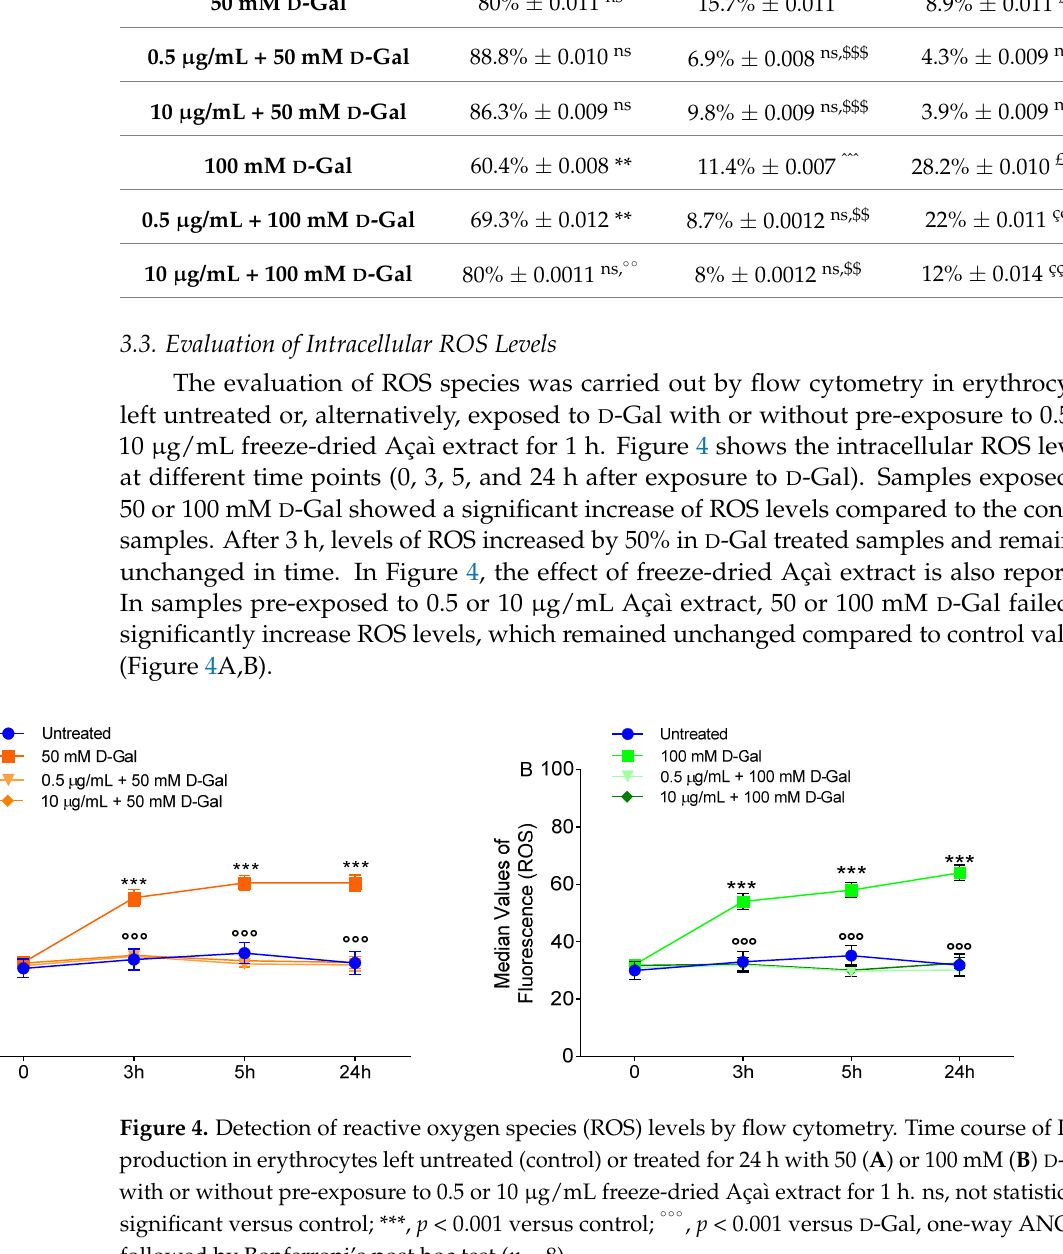
Table 1. Percentage of morphological alterations in erythrocytes left untreated (control) or treated as indicated. Data are presented as means ± S.E.M. from separate three independent experiments, where ns , not statistically significant versus untreated (biconcave shape, acanthocytes, and leptocytes); **, p < 0.01 versus control (biconcave shape); ◦◦ p < 0.01 versus 50 or 100 mM D -Gal (biconcave shape). ˆˆˆ , p < 0.001 versus control (acanthocytes); $$ , $$$ , p < 0.01 and p < 0.001 versus 50 or 100 mM D -Gal (acanthocytes). £ , £££ , p < 0.05, and p < 0.001 versus control (leptocytes); çç , ççç , p < 0.01 versus 100 mM D -Gal (leptocytes); one-way ANOVA followed by Bonferroni’s multiple comparison post-hoc test.